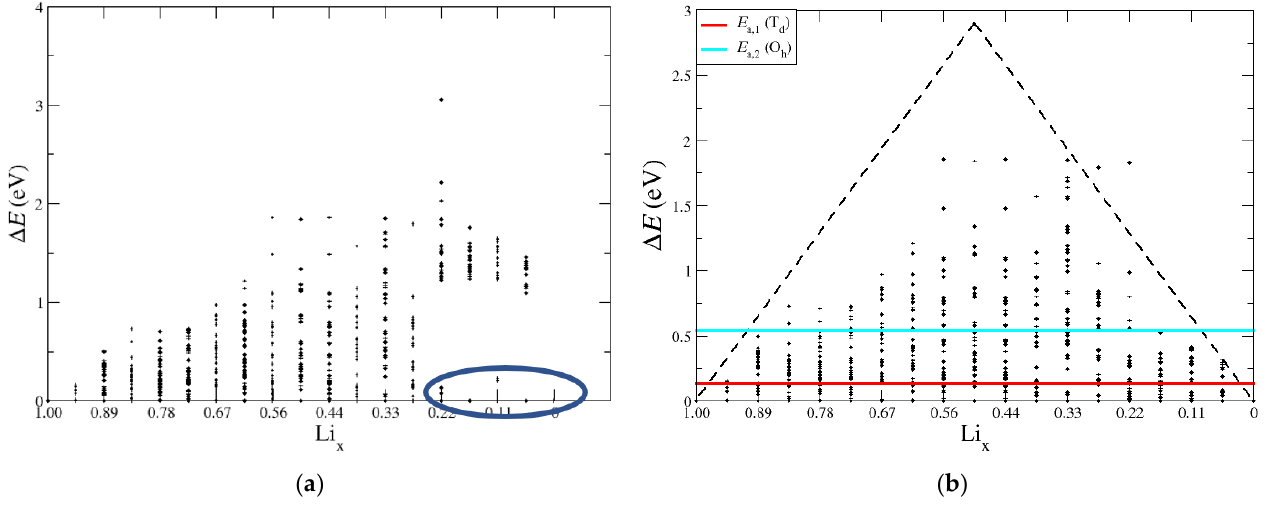
Figure 9. ( a ) Relative energies of lithium configurations with the lowest energy configuration set to zero at each Li x . Large changes in energy are observed at low Li x because of Ni displacement, indicated by the blue circle. ( b ) Relative energies with Ni displacement structures removed. T d and O h Li diffusion energy barriers are shown as red and cyan horizontal lines, respectively, to compare the configurations that are relatable by Li diffusion. The black dashed lines help to show the spread in energies where the largest deviations are around Li 0.50 .